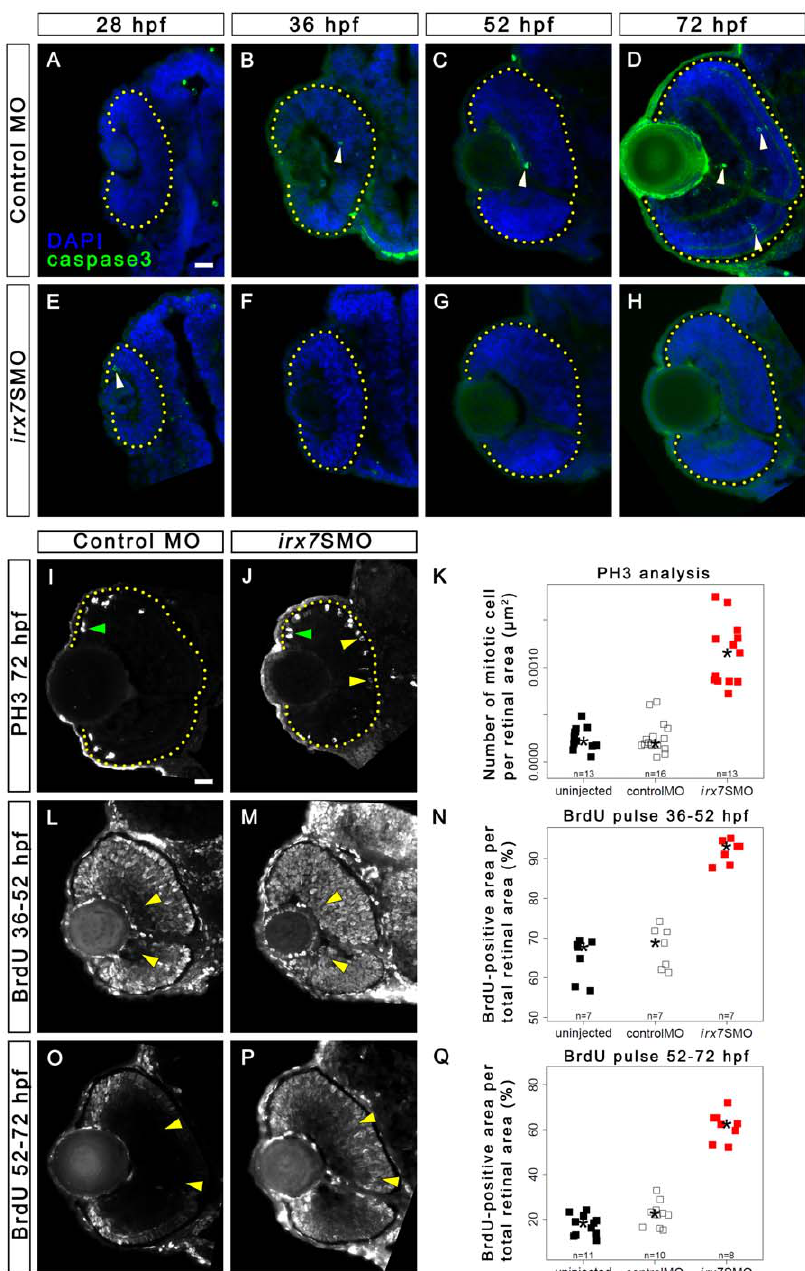
Figure 7. Irx7 knockdown does not induce apoptosis but can delay cell cycle withdrawal. Immunostaining of embryos injected with 10 ng of control MO or irx7 SMO were conducted with anti-active caspase3 antibody (green colour) at 28, 36, 52 and 72 hpf. The nuclei were counterstained with DAPI (blue colour). In both controls (A–D) and irx7 SMO morphants (E–H), only a few active caspase3 + cells (white arrowheads) were detected in some retinas at all stages. All cells that showed a positive anti-active caspase3 signal had the characteristic cell shrinkage and rounded morphology, as shown by the DAPI staining. While all active caspase3- cells looked healthy. Mitotic cells were detected by anti-PH3 in the retinas of controls (I) and morphants (J) at 72 hpf. PH3 + cells in the MZ and in the ectopic apical retina are indicated by green and yellow arrowheads respectively. (K) A stripchart of the number of PH3 + cell per retinal area in uninjected embryos, controls and morphants. Retinal cells that had gone through S-phase in controls and morphants were also detected by BrdU incorporation from 36 to 52 hpf (L and M) and from 52 to 72 hpf (O and P). (N and Q) The corresponding stripcharts of BrdU + area per retinal area in the uninjected embryos, controls and morphants. The asterisks in all stripcharts represent the median of each group. Lateral is to the left and dorsal is up for all sections. The retinal region in these samples is highlighted by a dotted yellow line. Scale bar=20 m m.